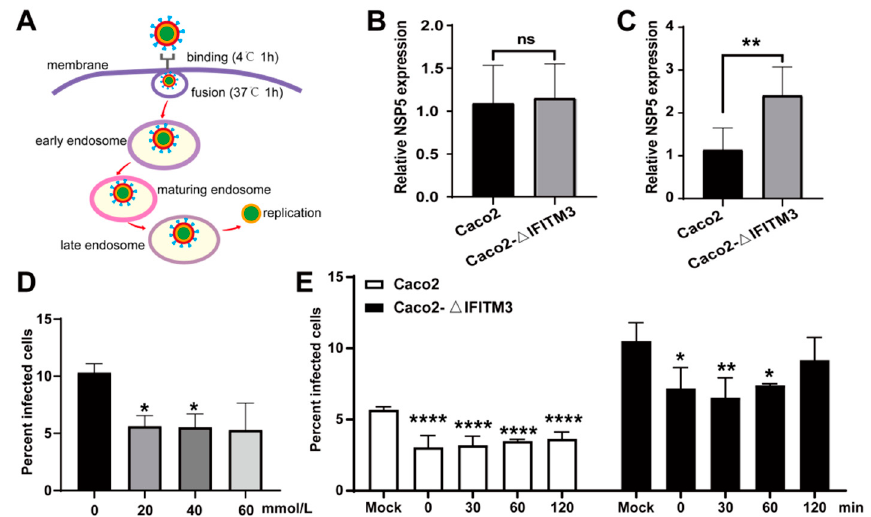
Figure 6. IFITM3 inhibits RV entry and delays Wa strain release from endosomes to cytoplasm in Caco2 cells. ( A ) The model of classical endocytic pathway of RV. Cell entry of the Wa strain began with the binding with glycans on the cell surface. After fusion with the membrane, RV was delivered from early endosomes to maturing endosomes, and finally reached late endosomes that provided the environment to enter the cytosol [28]. ( B ) RT–qPCR analysis of Wa–NSP5 in Caco2 and Caco2– Δ IFITM3 cells that were infected with Wa strain, respectively, at 5 MOI at 4 °C for 1 h. ( C ) RT–qPCR analysis of Wa–NSP5 in Caco2 and Caco2– Δ IFITM3 cells that were incubated, respectively, at 37 °C for a further 1 h after binding. ( D ) Flow cytometry analysis of the percentage of infected Caco2 cells after NH4Cl treatment in different concentrations. ( E ) Flow cytometry analysis of the percentage of infected Caco2 and Caco2– Δ IFITM3 cells after 20 mM NH4Cl treatment. Results represented the mean ± SD and were measured in technical duplicates, n = 3. ns, p > 0.05; *, p < 0.05; **, p < 0.01; ****, p < 0.001 (Student’s t test).